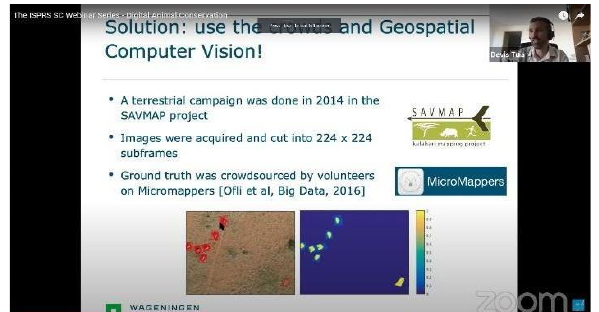
Figure 4 . Dr. Devis Tuia provided details on how UAVs, together with field surveys, supported wildlife conservation.